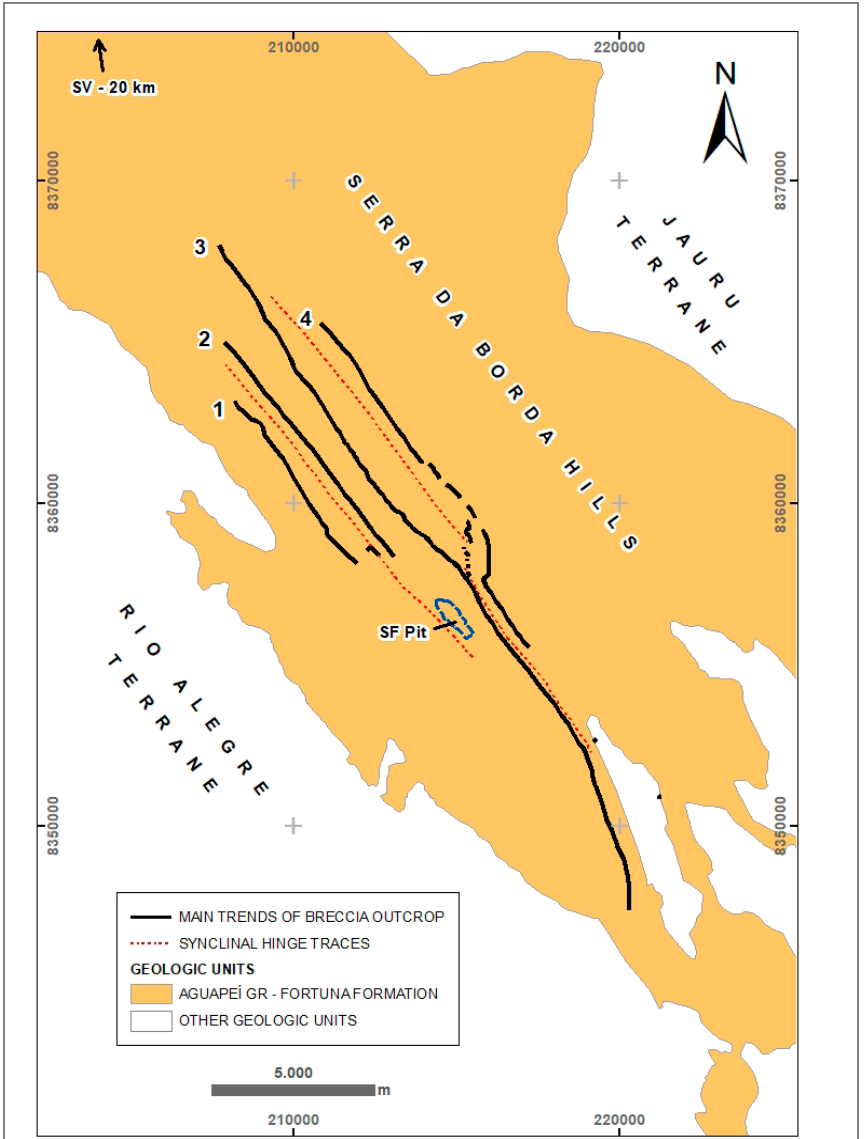
FIGURE 3 - Simplified geology map of the area outlined in figure 1, showing the main trends of the breccias in the vicinities of the São Francisco mine, Serra da Borda hills (modified after Lacerda Filho et al. 2004 and Scabora 2014, with additional data from one of the authors of this article). Location of the São Francisco (SF) mine pit and the São Vicente (SV) deposit